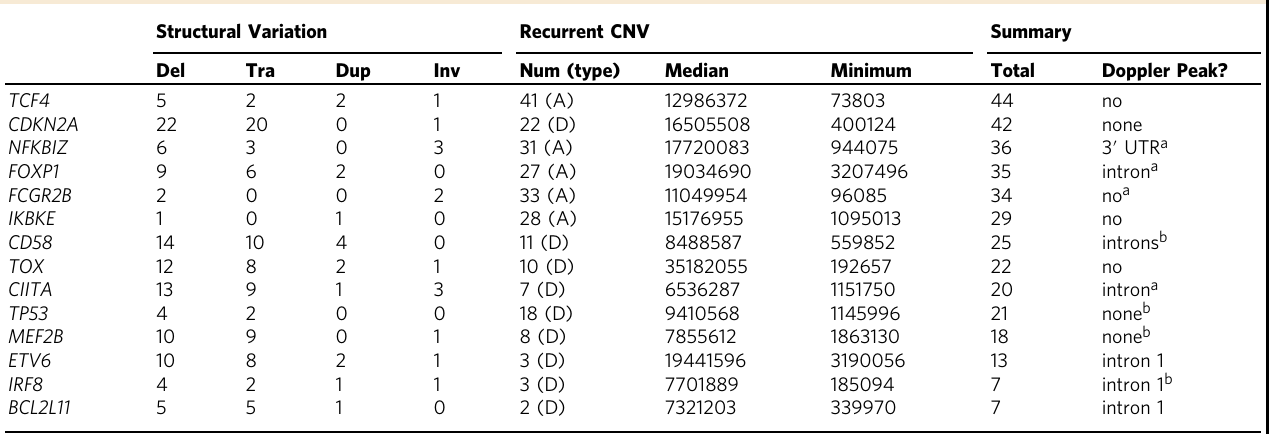
Table 1 Overview of SVs and CNVs proximal to genes detected by WGS Structural Variation Recurrent CNV Summary